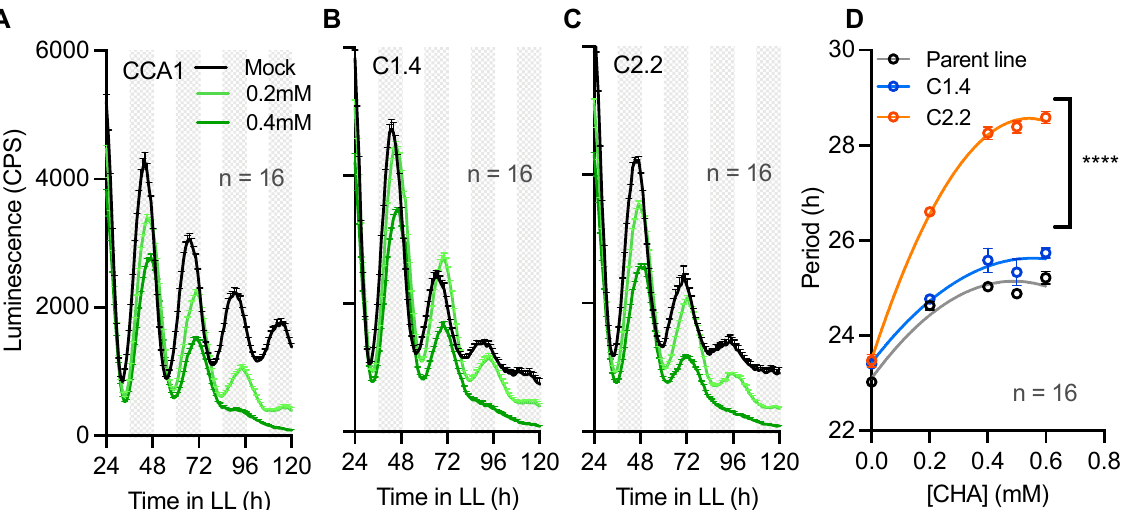
Figure 4. CNNM2 activity acts synergistically with magnesium transport inhibition. CCA1-LUC luminescent traces in response to CHA treatments under LL for CCA1 (parent line, ( A )), CNNM1ox ( B ), and CNNM2ox ( C ) and period analyses to a range of [CHA] ( D ). Data are presented as the mean ± SEM. n = technical replicate number, h = hours. **** = p < 0.0001; statistical analyses are compared with the parent line; two-way ANOVA.